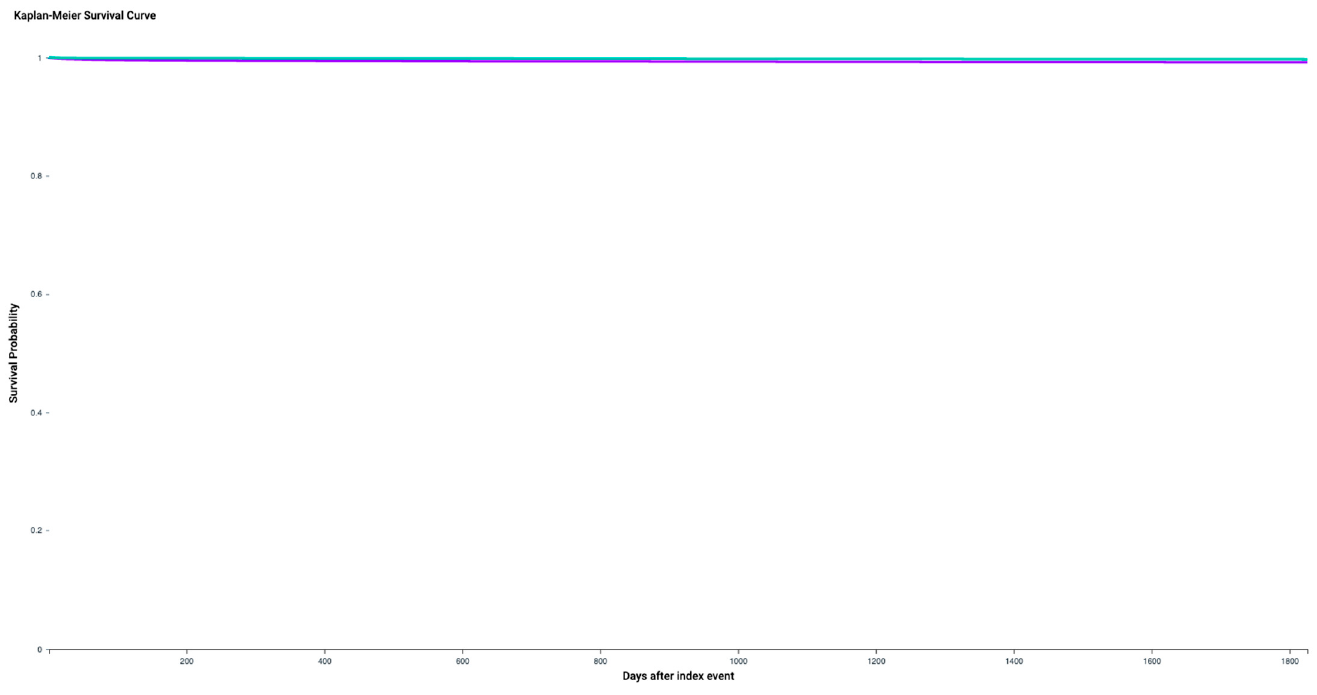
Figure 2. Number of patients with and without recurrent aphthous stomatitis (RAS; ICD-10 code K12), and risk of oral squamous cell carcinoma.